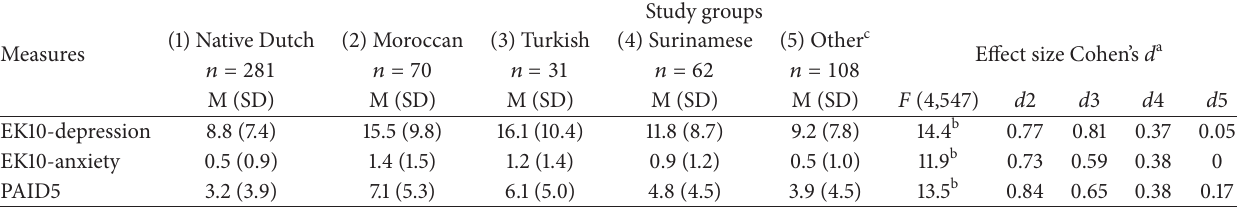
Table 3: Mean EK10- and PAID5-scores, standard deviations, F tests, and effect sizes for native Dutch compared to other ethnic groups.